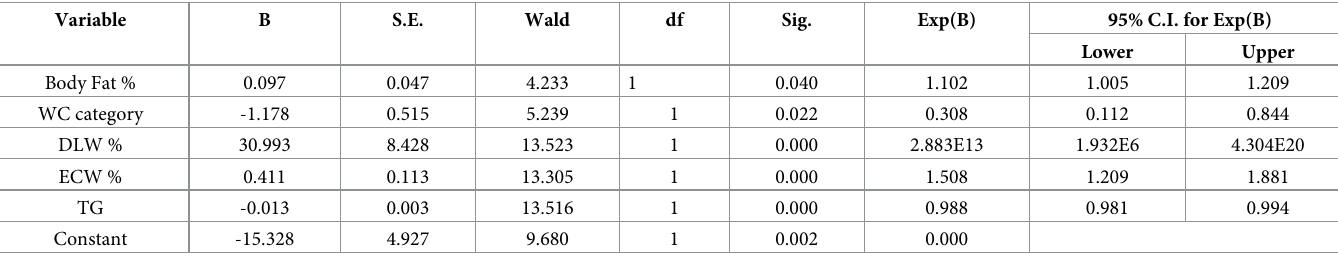
Table 5. Association of PD with anthropometric indices, body composition parameters and lipid profile.